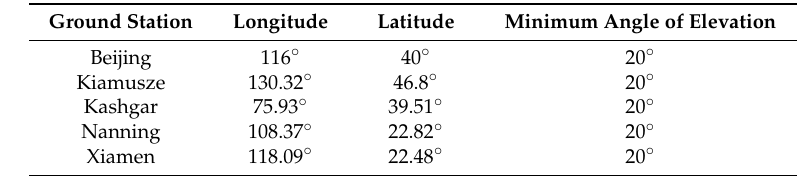
Table 2. Ground Station